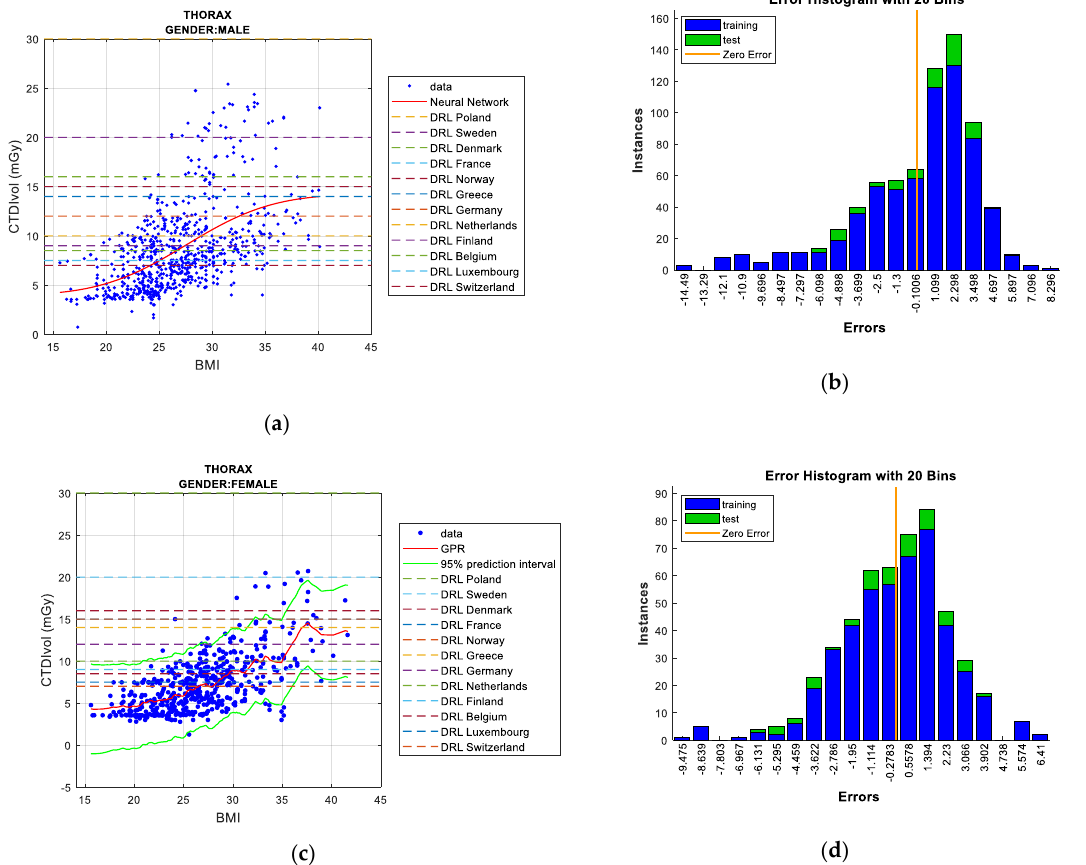
Figure 8. CTDI VOL prediction according to BMI including European DRLs for men’s / women’s thorax protocol ( left ), together with error histograms ( right ), employing the Neural Networks ( a , b ) for men and the GPR ( c , d ) for